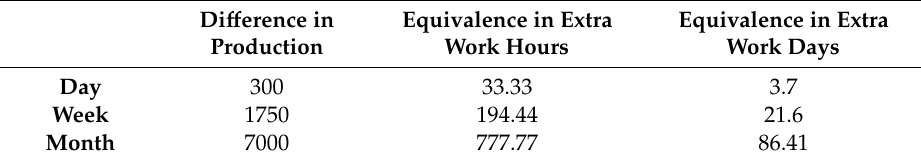
Table 1. Di ff erence in production and equivalence in extra work